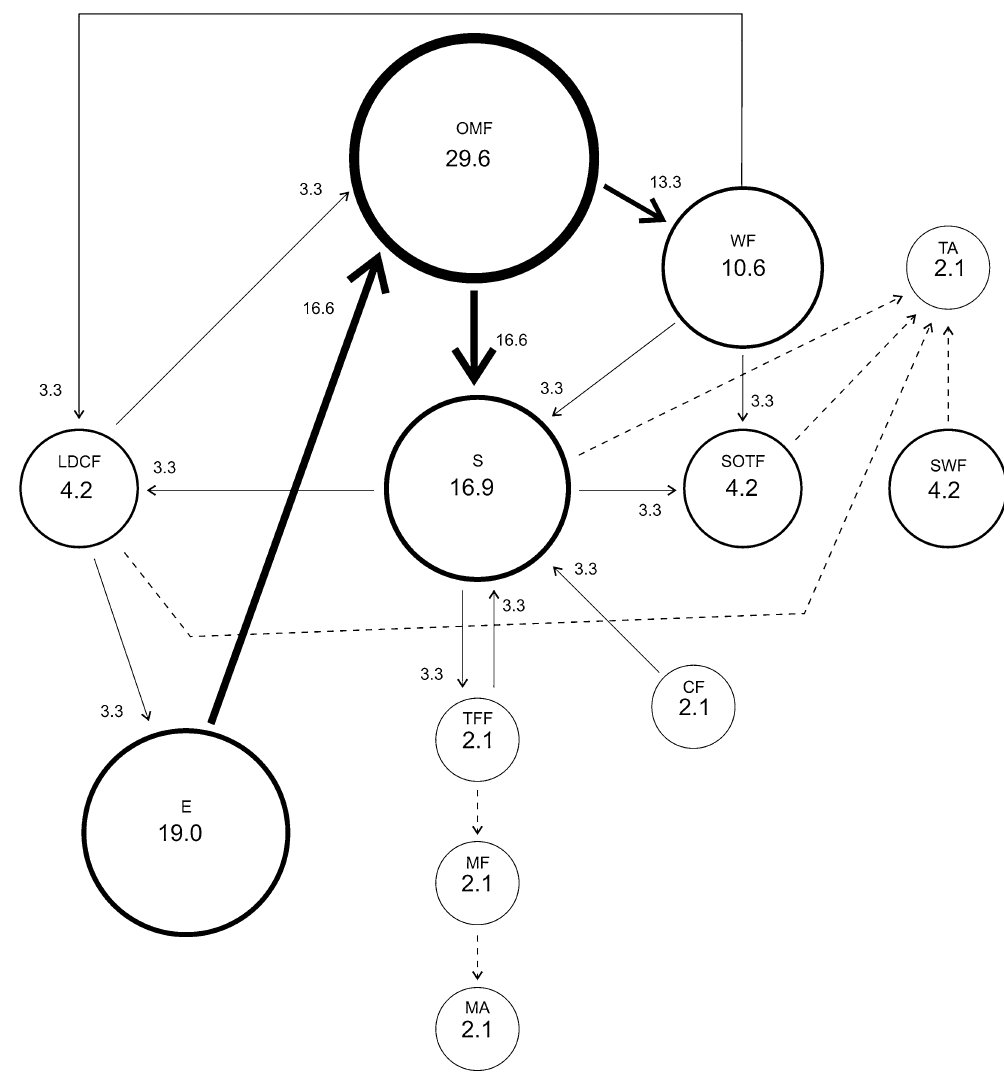
Figure 6. Courtship behavior of Anastrepha curvicauda subordinate 7–8 days old males caged with a 5–7 days old virgin female and a dominant male. Choice experiment. Circle size and line thickness are proportional to their percentage values. Dotted lines represent transitions with a median < 1. See Table 1 for abbreviations.